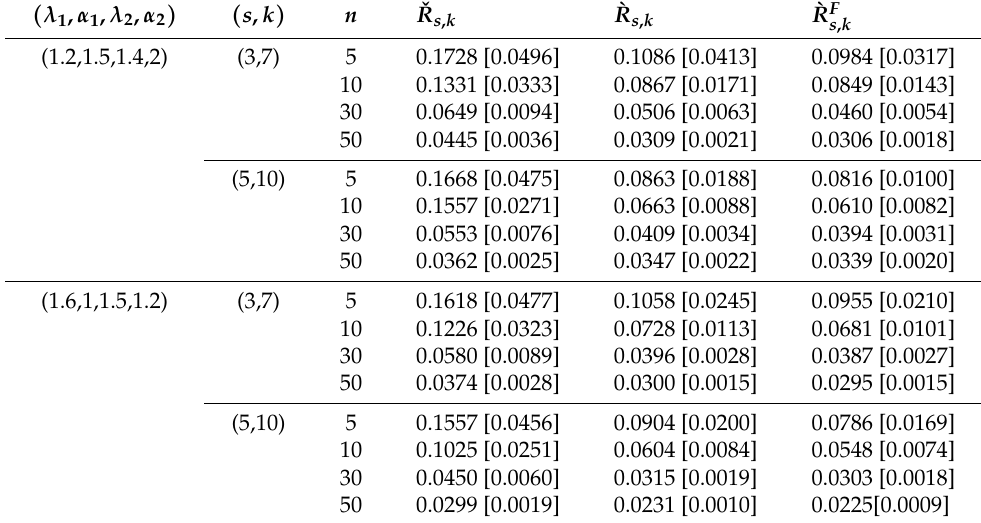
Table 3. ABs and MSEs (within bracket) for R s , k with unequal